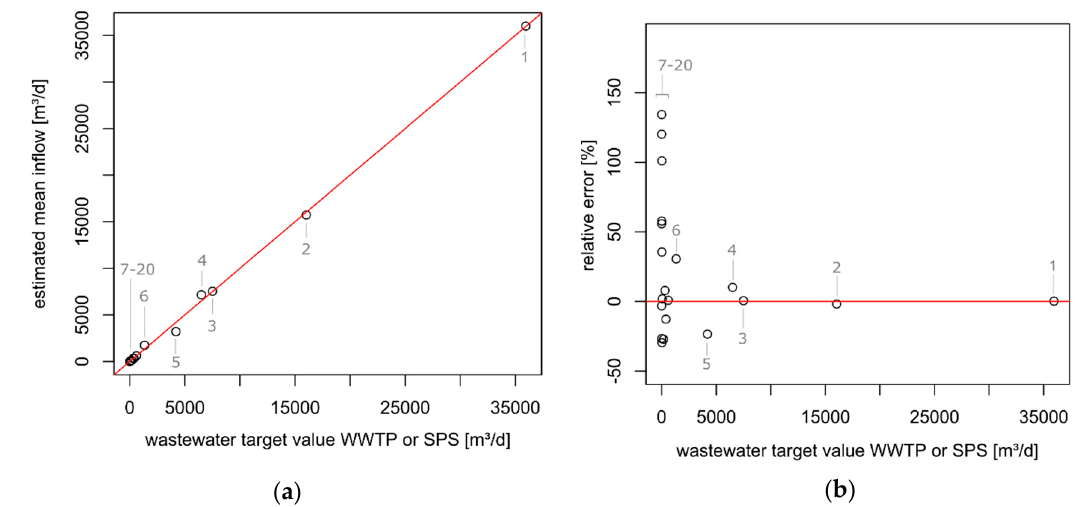
Figure 7. ( a ) Generated inflows to wastewater treatment plants and pumping stations, numbers of SPSs and WWTPs (gray) refer to Figure 1 and Table A1; ( b ) relative error related to the inflow target value.